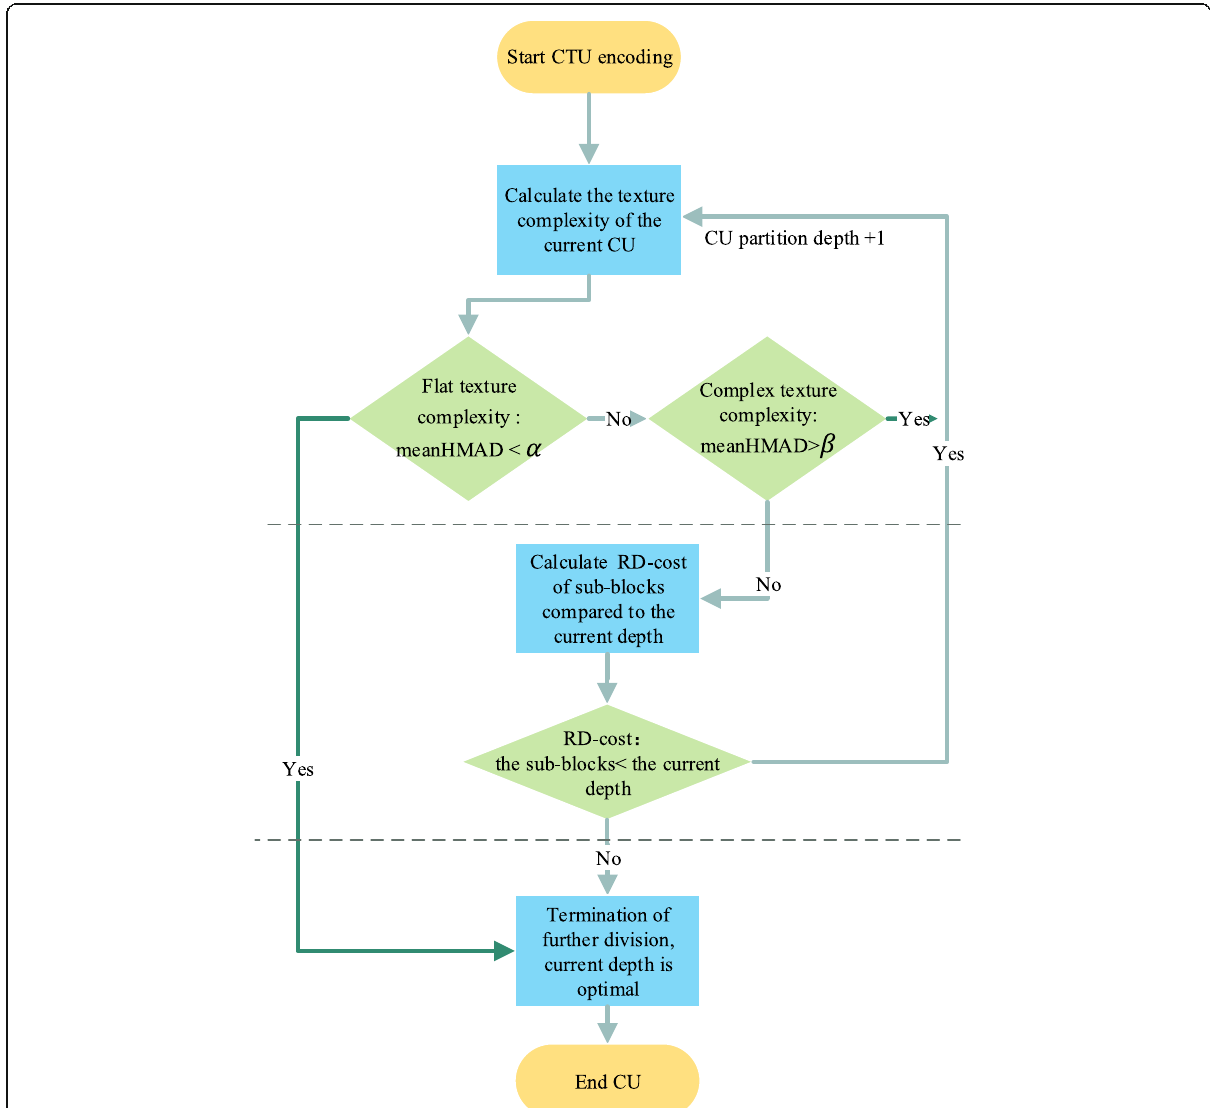
Fig. 8 Schematic of the proposed CU size decision algorithm based on texture